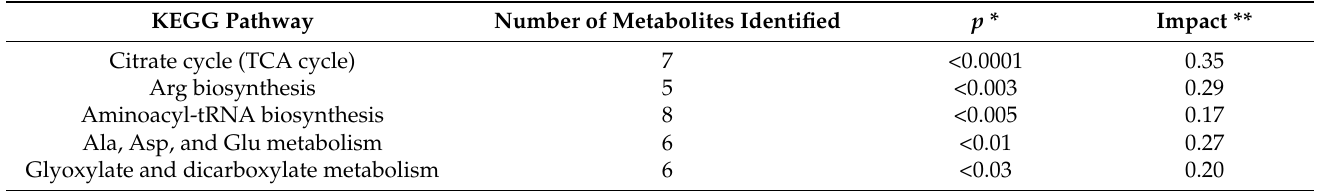
Figure 3. Pathway analysis of 53 differential metabolites and five major metabolic pathways *: (1) citrate cycle; (2) Arg biosynthesis; (3) aminoacyl-tRNA biosynthesis; (4) Ala, Asp, and Glu metabolism; (5) glyoxylate and dicarboxylate metabolism. * Only the pathways with statistical significance are highlighted. Table 2. The major metabolic pathways * involved in 53 differential metabolites (between experimental groups).